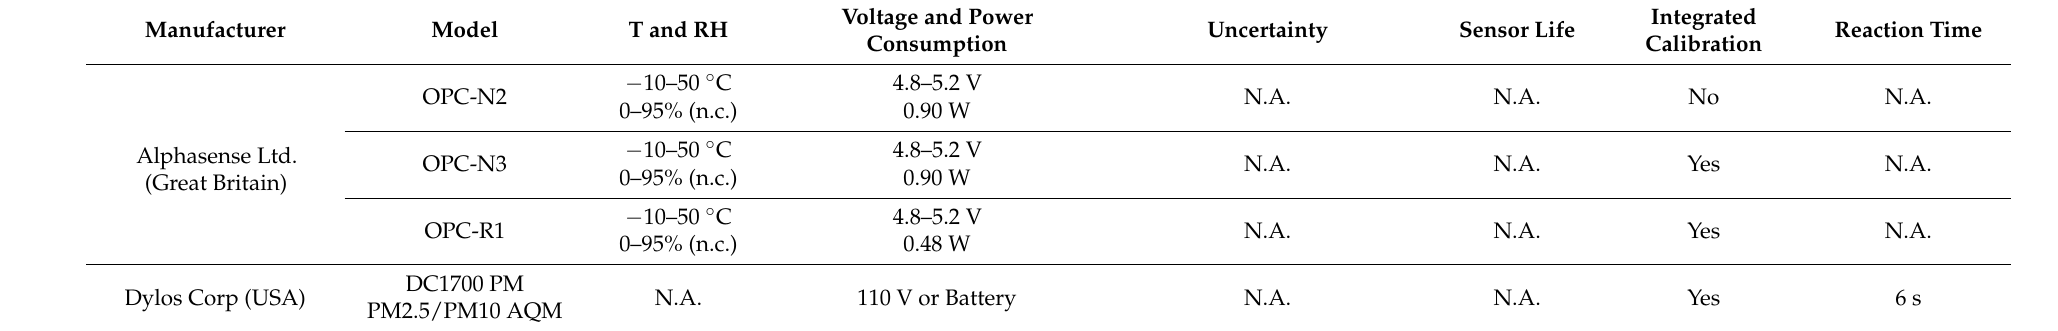
Table 2. Electrical and performance characteristics of low-cost PM sensors with the name of the manufacturer, model number, operating temperature (T) and relative humidity (RH) range, nominal voltage and maximum power consumption, uncertainty, sensor life, availability of calibration, and the reaction time in seconds (s); “n.c.” stands for “non